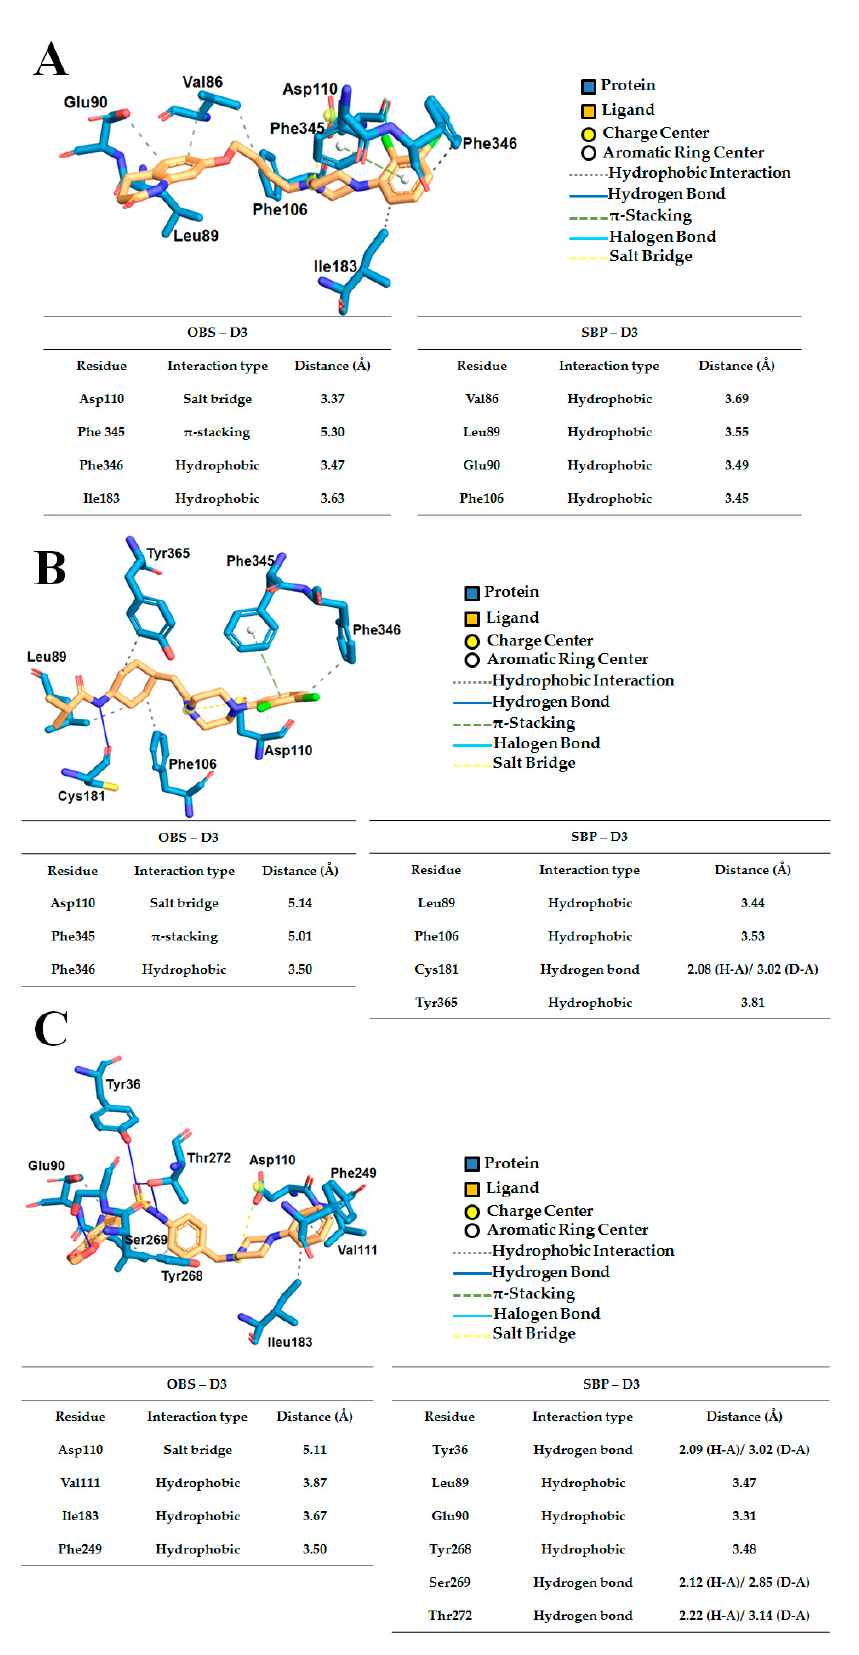
Figure 4. PLIP analysis for the prototype compounds aripiprazole ( A ) and cariprazine ( B ), and for 5a ( C ), at D3 receptors.